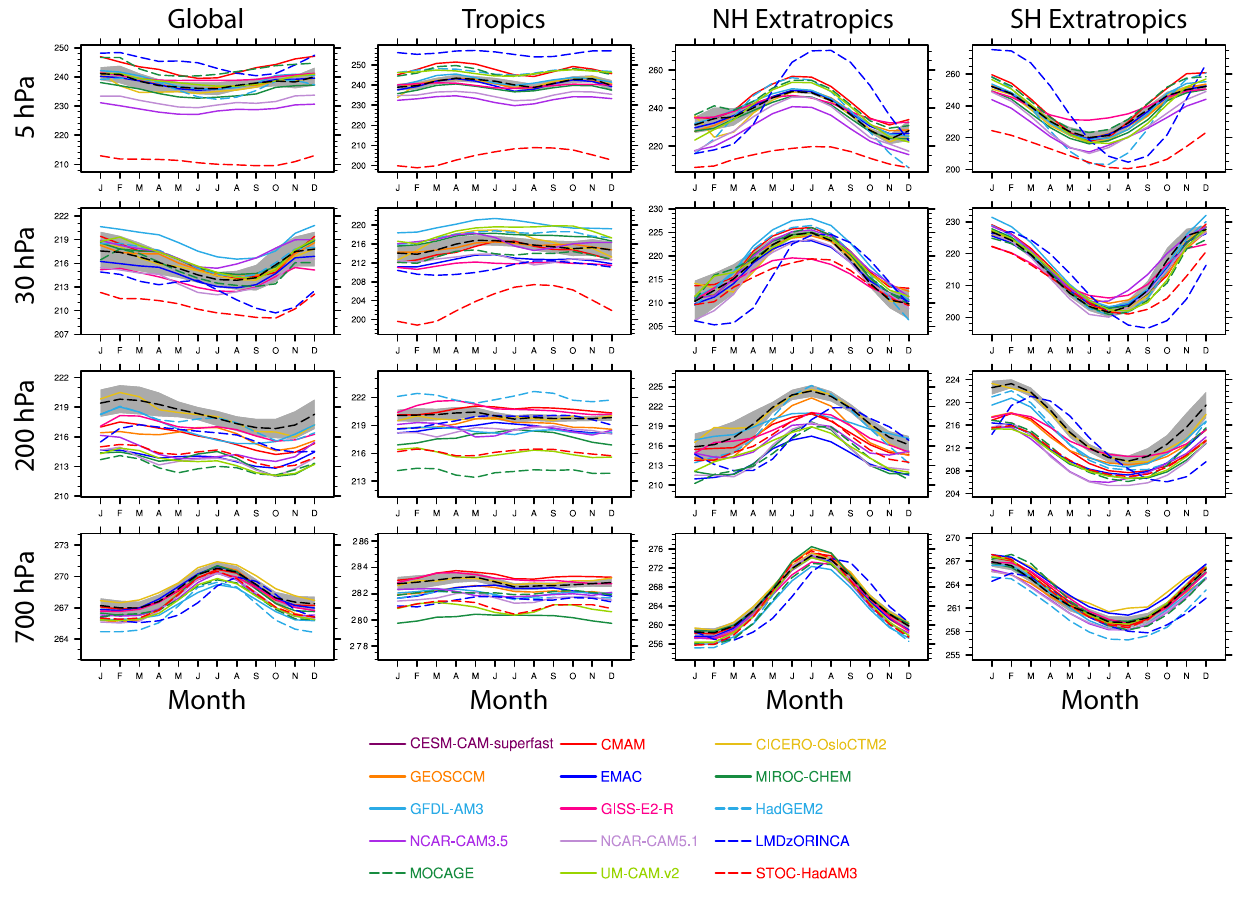
Fig. 6. Seasonal cycle of temperature (K) at 4 pressure levels for all models and the ERA-Interim reanalysis.